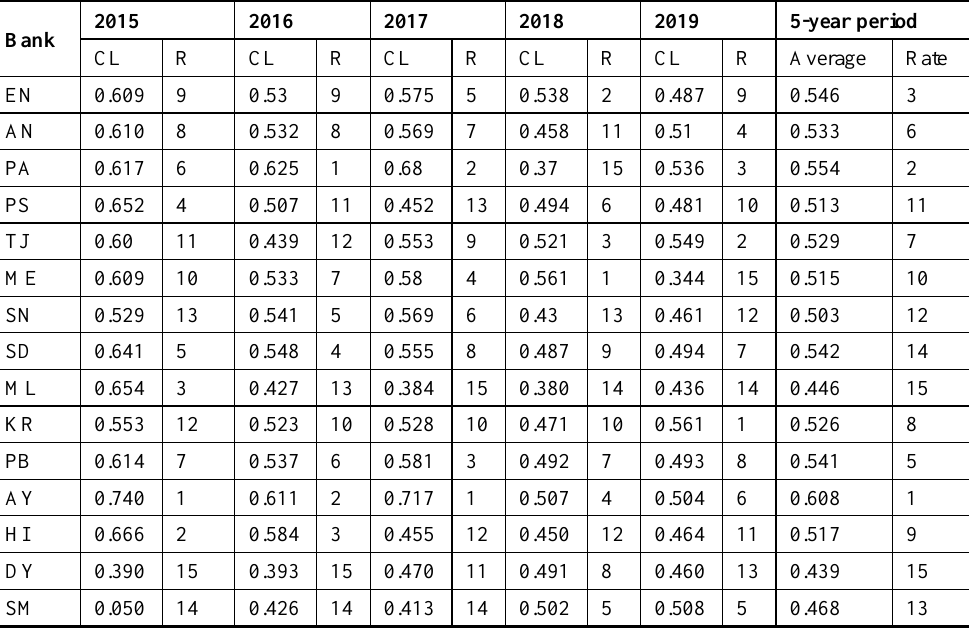
Table 4. Banks' rates based on early warning system